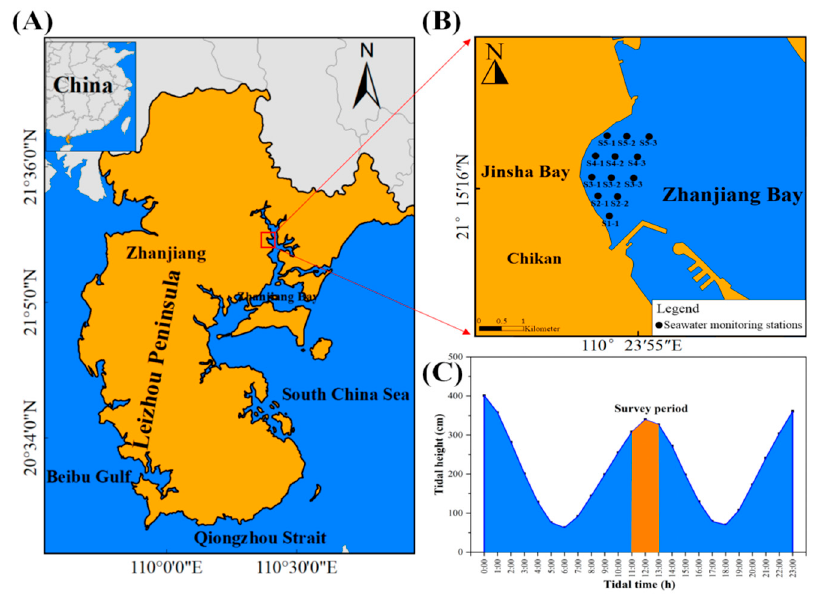
Figure 1. Geographical location of Zhanjiang Bay (ZJB) ( A ), Jinsha Bay ( B ), and tidal variation in ZJB ( C ).